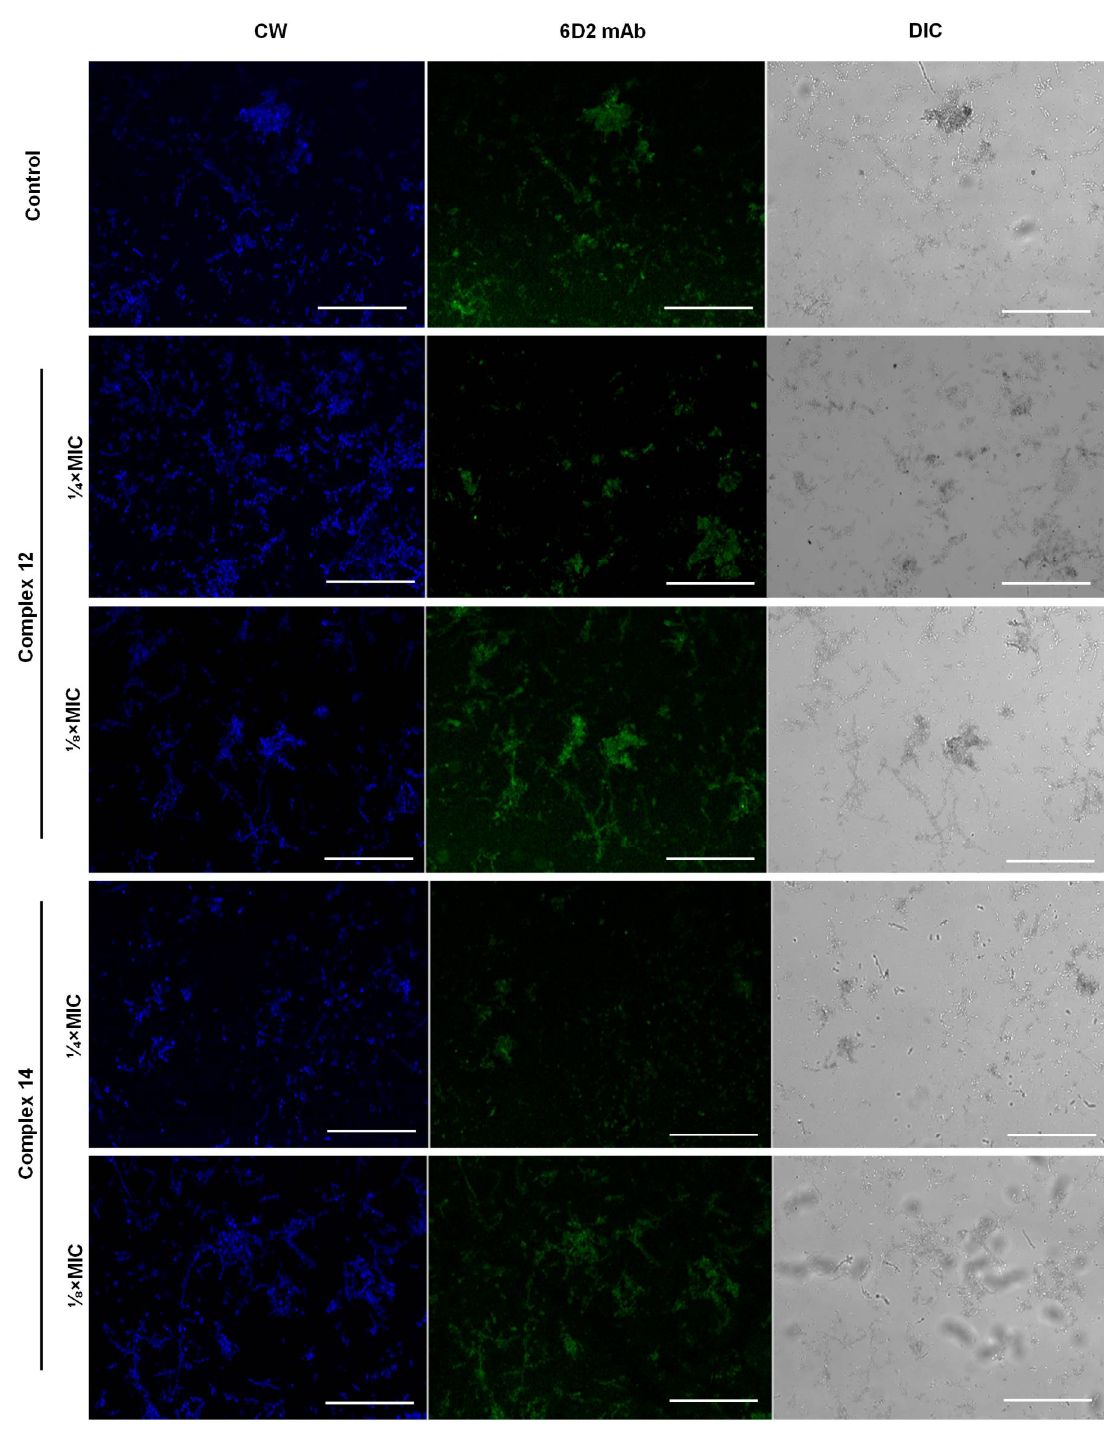
Figure 4. Effect of silver-phen complexes on F. pedrosoi melanin production. Fluorescence microscopy of fungal cells grown in the absence (control) and in the presence of silver complexes at different concentrations for 5 days at 26 °C, and then labeled with 6D2 mAb followed by incubation with anti-mouse IgM-Alexa 488 and calcofluor white (CW), as detailed in Material and Methods. Images were obtained using differential interference contrast (DIC) and fluorescence microscopy. Scale Bar: 50 µm. Note that all the cells treated with non-inhibitory concentration of ¼×MIC of both silver complexes were stained with calcofluor; however, most of them were not labeled with 6D2 mAb, showing that these cells had their melanin production inhibited.